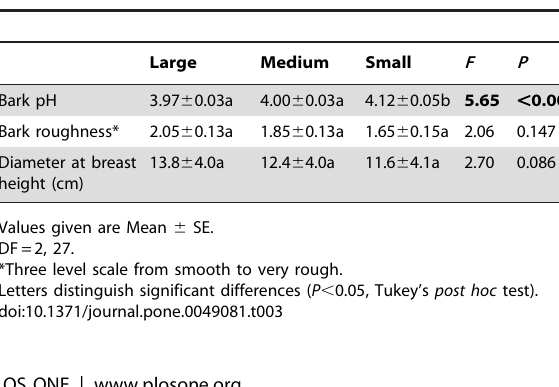
Table 3. ANOVA results for properties of B. pubescens measured across the three island size classes.